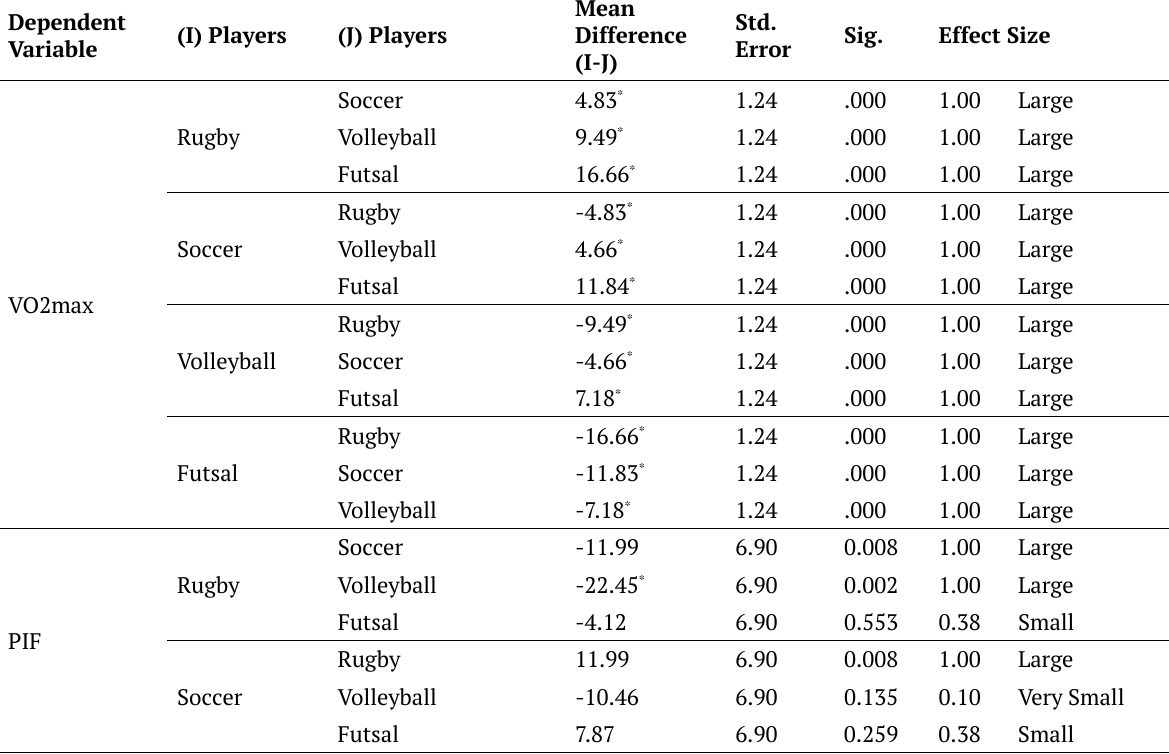
Table 3. Post-Hoc (LSD) and effect-size Analysis of physiological output values of athletes from random intermittent dynamic type